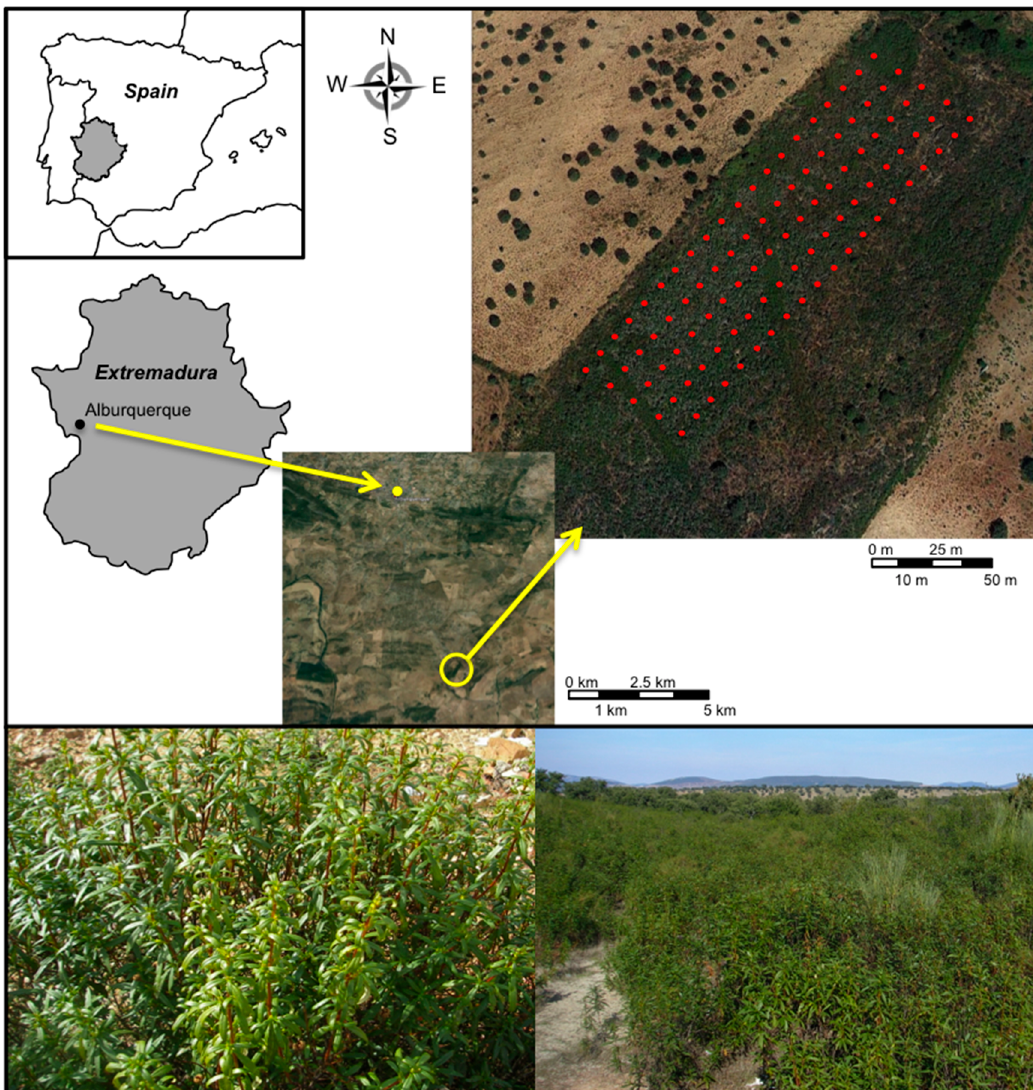
Figure 5. Location of the study area. Each red dot represents an individual. A view of an individual and a shrubland dominated by rockrose C. ladanifer .